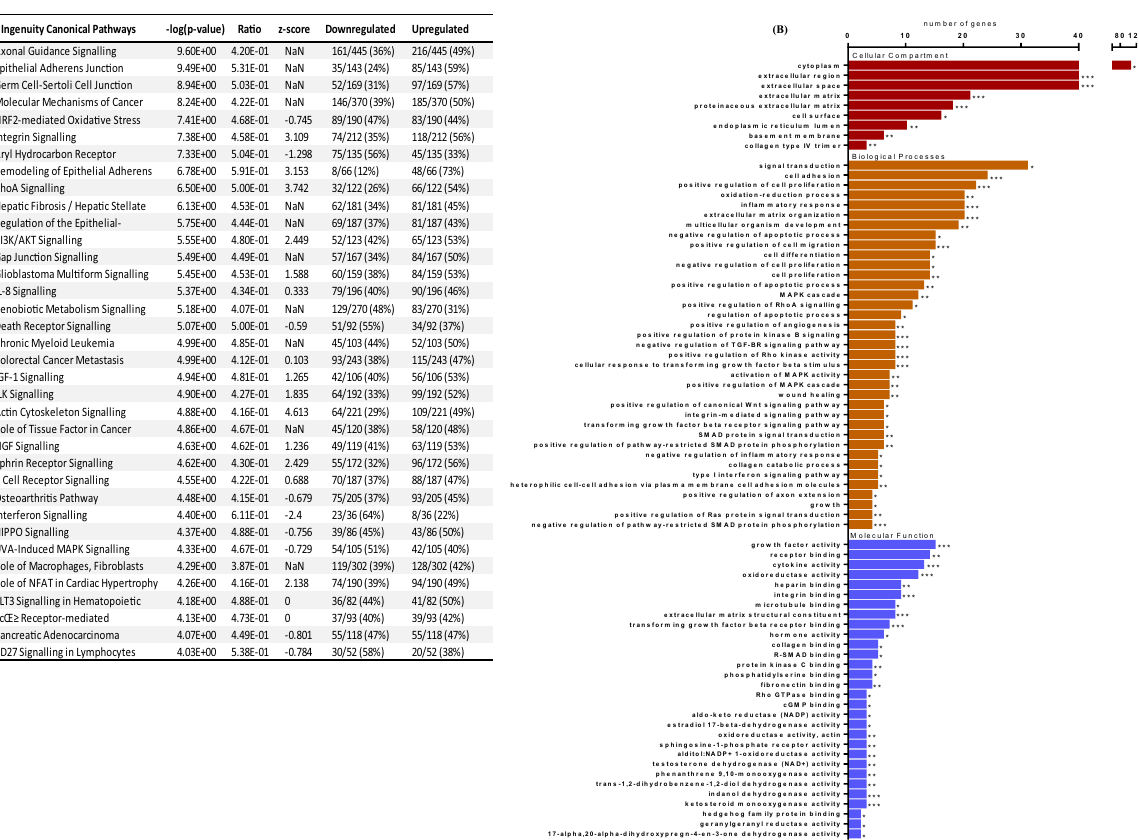
Figure 2. Gene Ontology and canonical pathway analysis. ( A ) A table showing significant biological processes and canonical pathways from IPA for the differentially expressed genes found between donor control and TGFβ2 donor treated. ( B ) Gene Ontology (GO) analysis of the top 50 upregulated and downregulated genes investigating the cellular compartment, biological processes, and molecular functions of the top 50 upregulated and 50 downregulated genes analysed using the DAVID functional process on R. *p < 0.01, **p < 0.001, ***p <